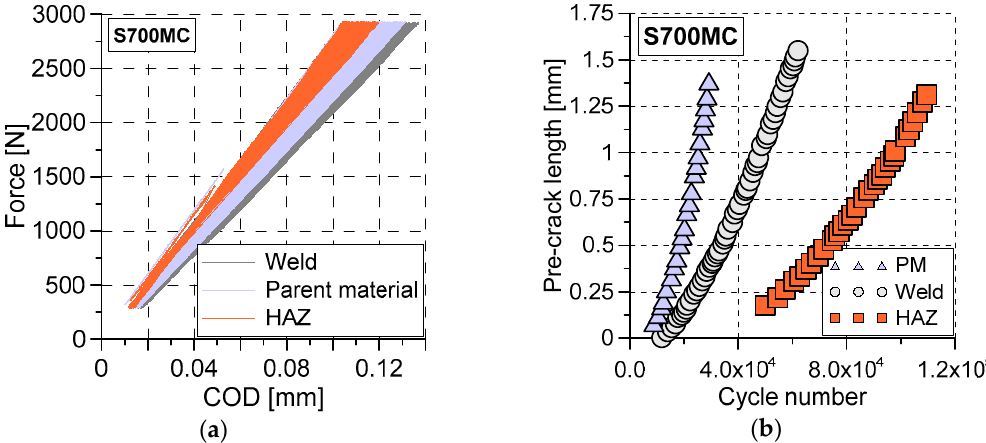
Figure 10. Results of CTOD experiments: ( a ) force versus COD; ( b ) pre-crack length-cycle number for the parent material (PM), weld and HAZ. Materials 2020 , 13 , x FOR PEER REVIEW